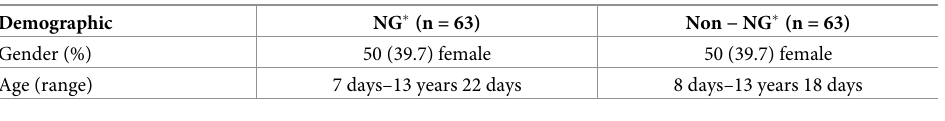
Table 2. Patient demographics.